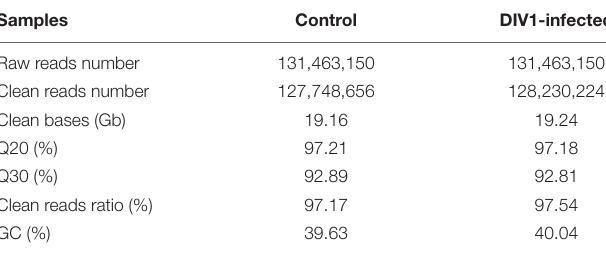
TABLE 2 | Summary of clean reads statistics by Illumina sequencing.